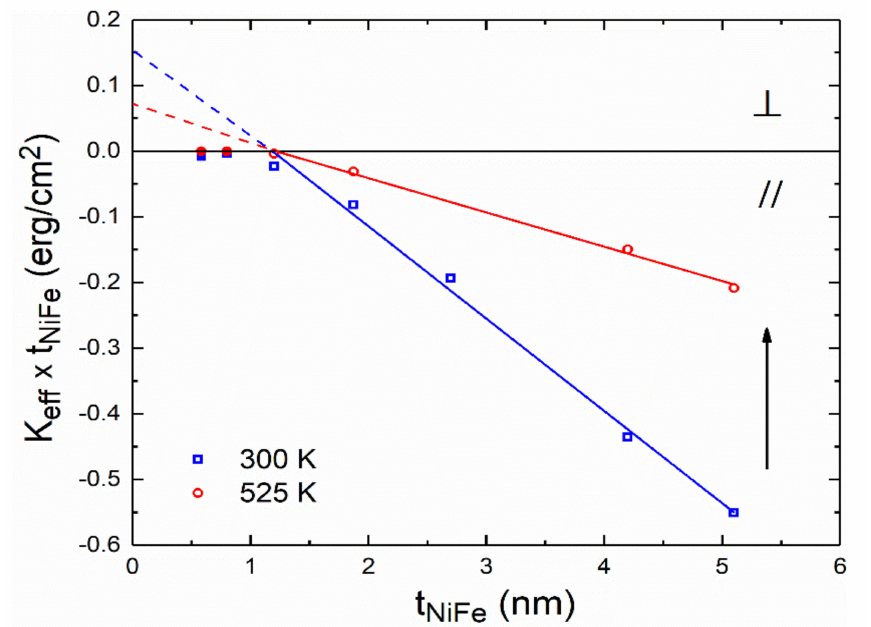
Figure 5. Dependence of the effective magnetic anisotropy constant K eff × t NiFe on t NiFe , for NiFe/NiFeO multilayers at room temperature (open rectangular) and after annealing at 525 K for 90 min (open circles) for all multilayers of Table 1. The arrow indicates the shift on the slope of the plot for the annealed samples. For the quantitative analysis of this plot, we have used only data for multilayers with continuous magnetic layers, that is, t NiFe > 1